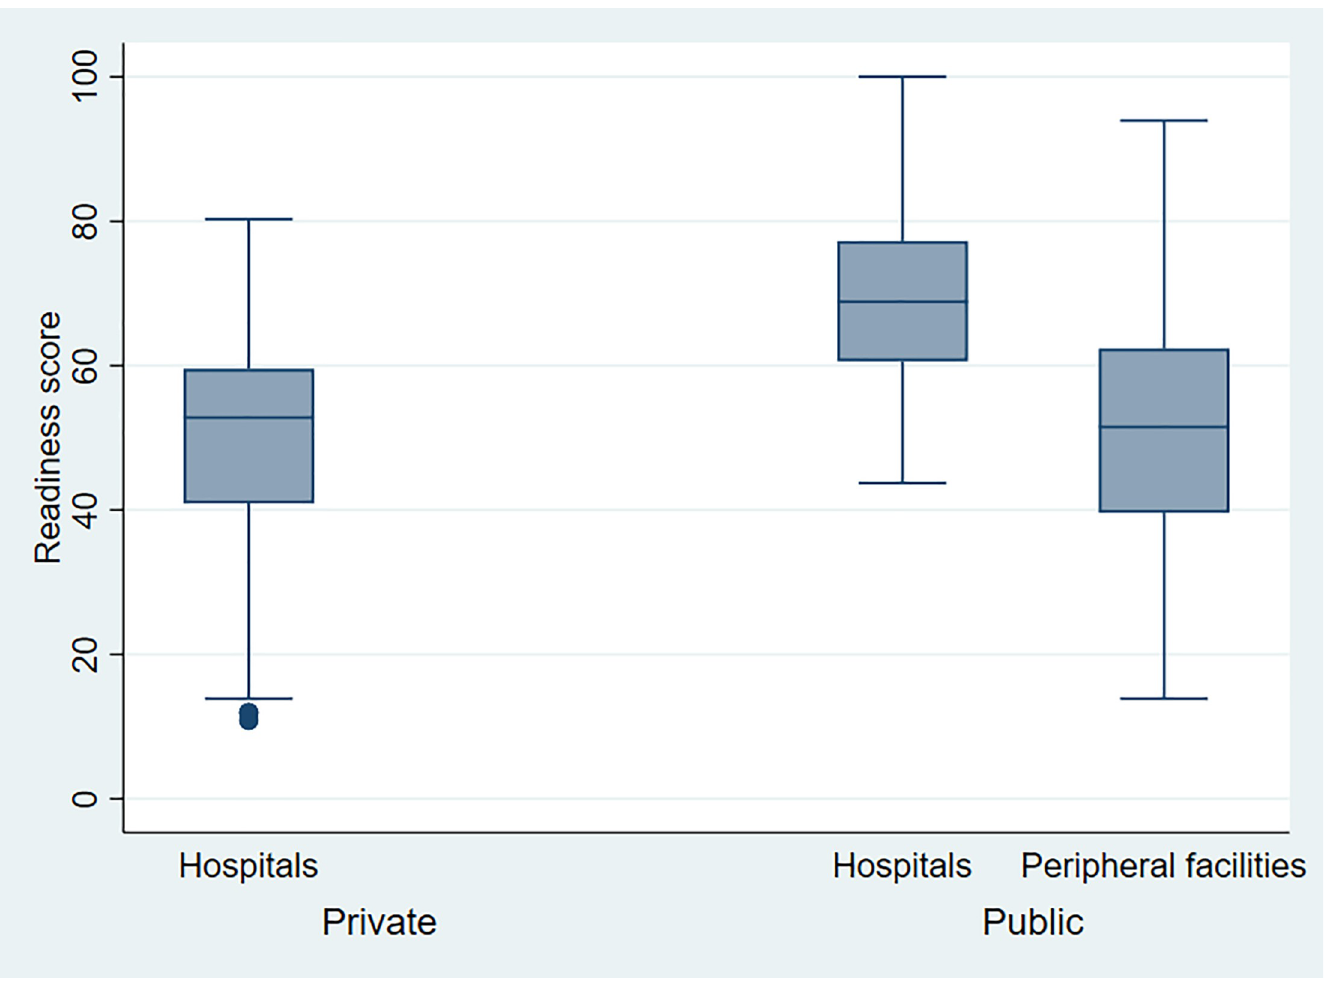
Fig 3. Overall readiness score of BEmONC by the type of